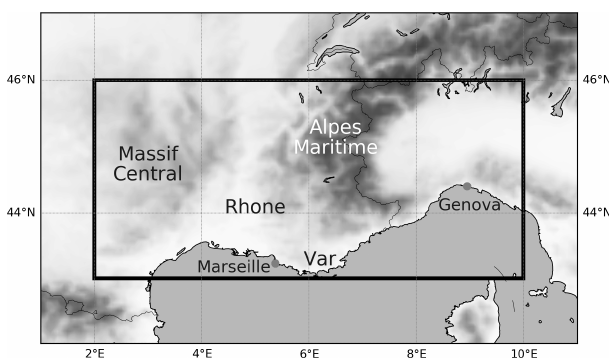
Figure 1. Map illustrating the northwestern Mediterranean domain (black box) and geographical landmarks used in the